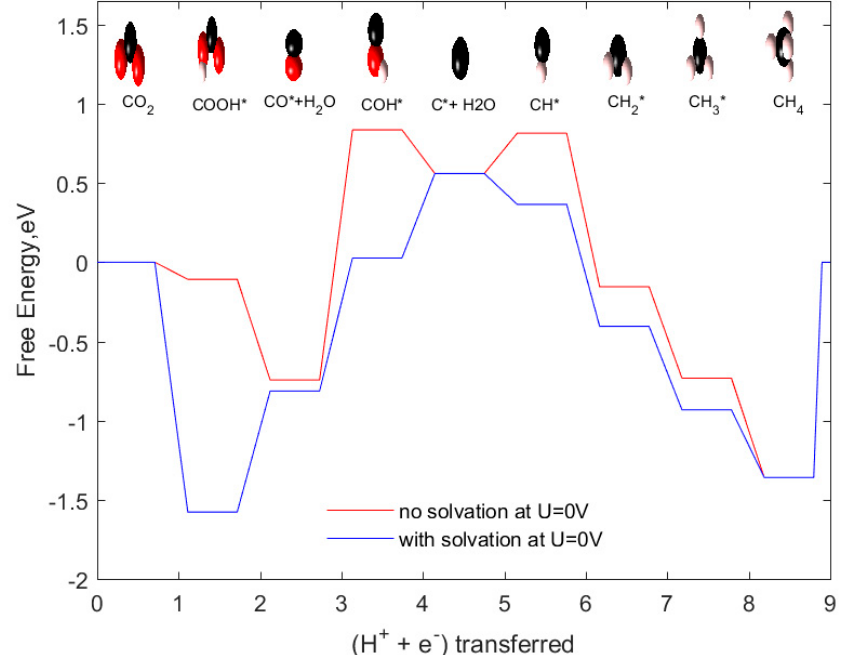
Figure 5. Lowest energy pathway of CO 2 reduction to CH 4 on the WC/graphene. Red: excluding the solvation effect. Blue: including solvation effect. Color code of atoms: red: oxygen, black: carbon, white: hydrogen.